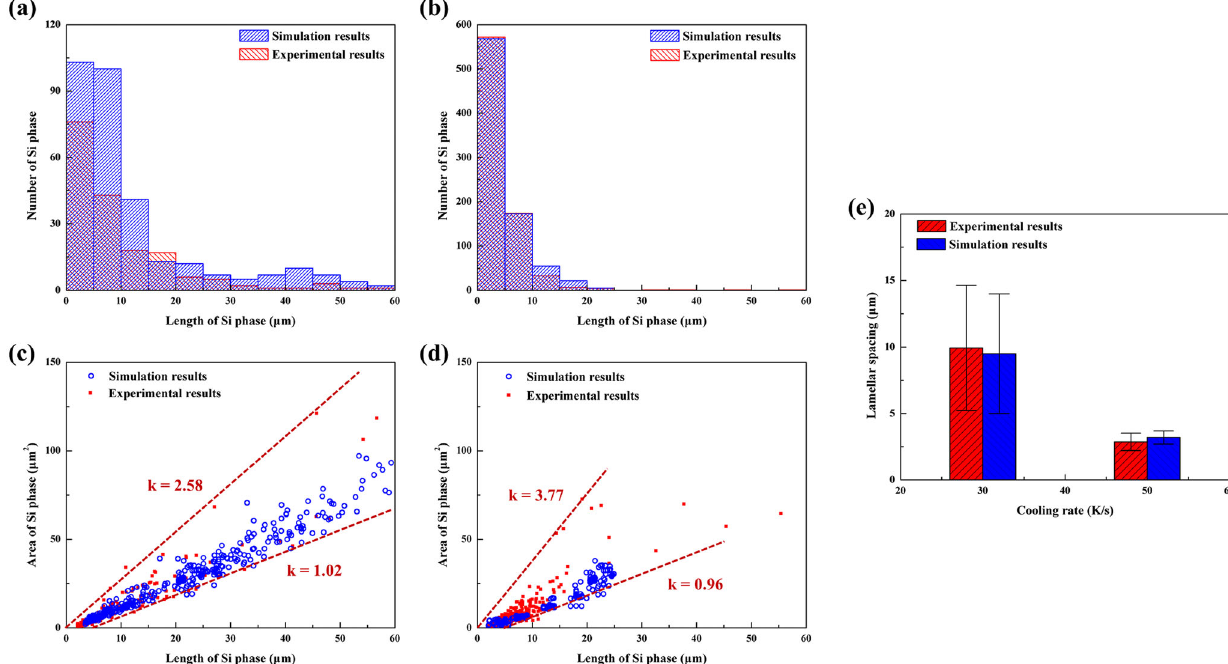
Fig. 6 Quantitative results of Si phase. Quantitative results compared between simulation results and experiment results: a Number of Si phase vs. length of Si phase with a cooling rate of 30 K s − 1 , b number of Si phase vs. length of Si phase with a cooling rate of 50 K s − 1 , c area of Si phase vs. length of Si phase with a cooling rate of 30 K s − 1 , d area of Si phase vs. length of Si phase with a cooling rate of 50 K s − 1 , and e average lamellar spacings between Si phase under different cooling rates (The error bars are obtained from the standard deviations of the lamellar spacings in the domain).